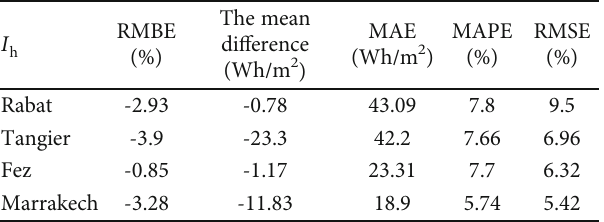
Figure 6: Graphical representation of the estimated values according to the measured values for various models to estimate I Hollands model; (b) De Miguel et al. model; (c) Erbs et al. model; (d) our I d model. Table 10: The performance of used model for predicting the global